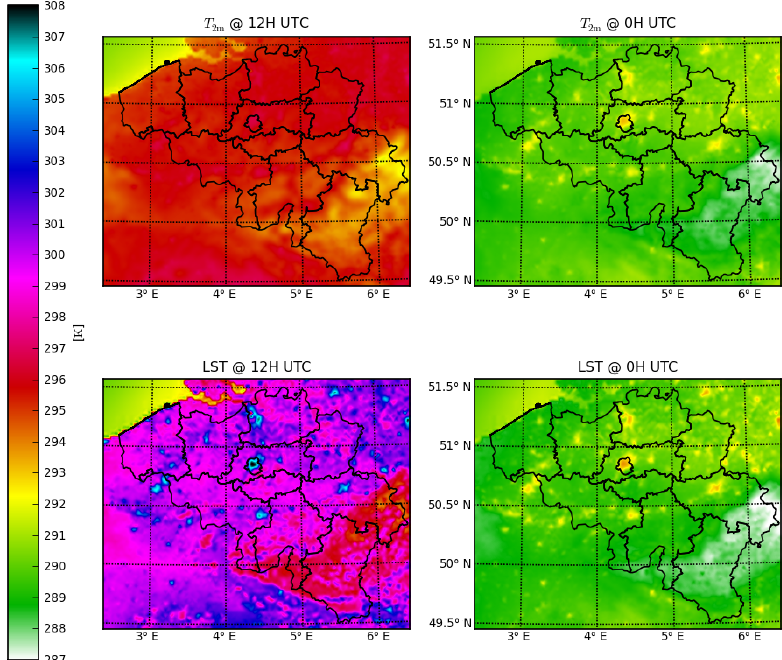
Figure 2. Modelled horizontal profiles of screen-level (top panels) and surface (bottom panels) temperatures at noon (left panels) and midnight (right panels), averaged for 21 July to 20 August